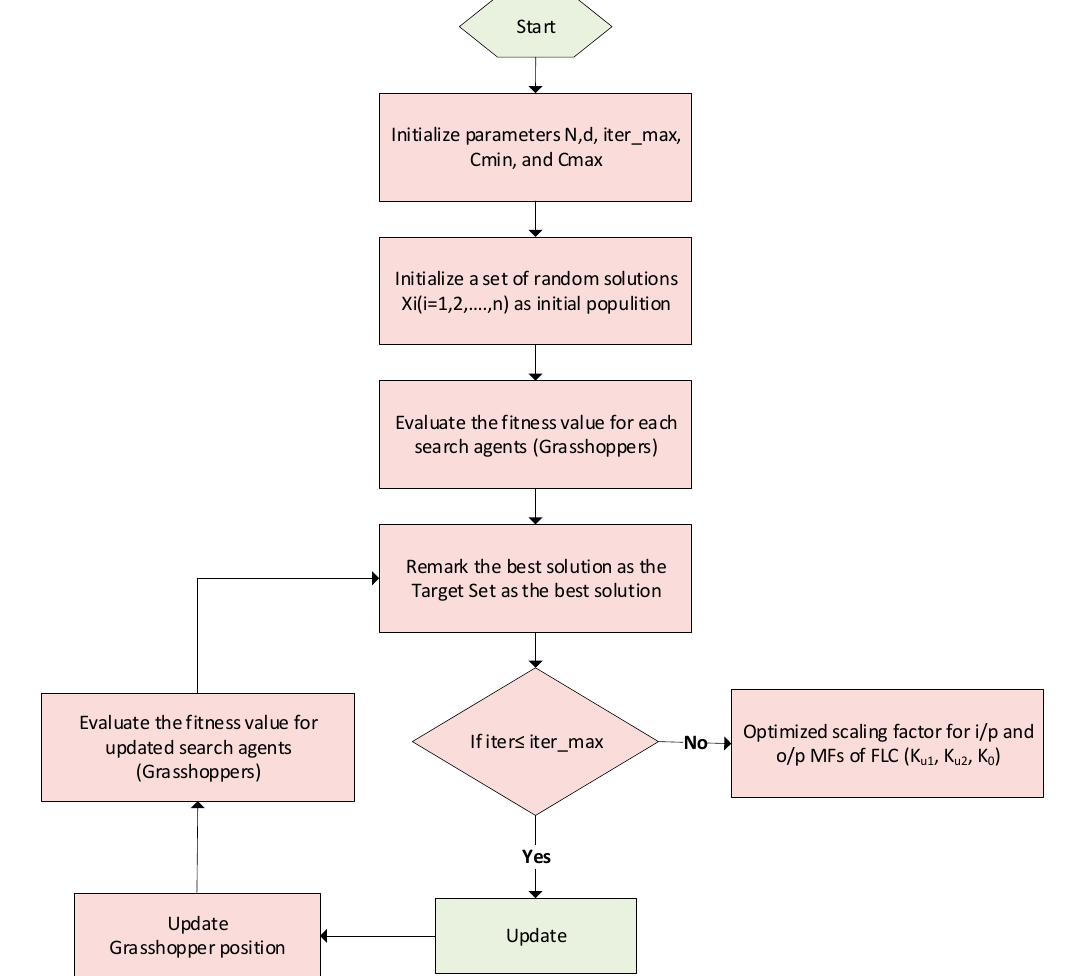
Figure 30. Flowchart of grasshopper adaptive fuzzy logic control (FLC) MPPT.